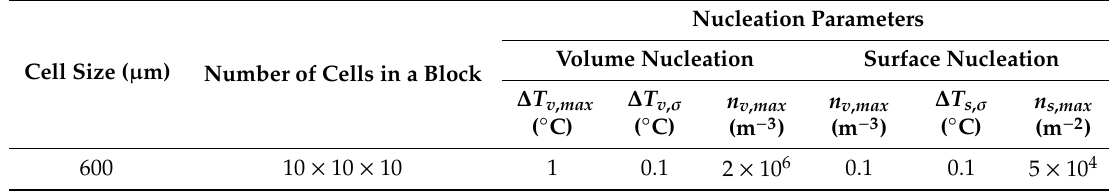
Table 2. Parameters for microstructure CAFE model of DC casting process.